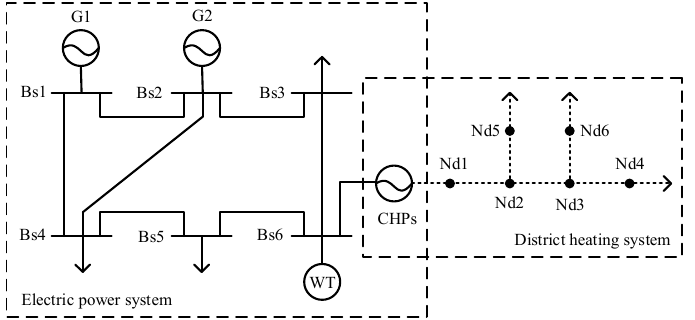
Figure 4. Configuration of the six-bus and six-node integration system.